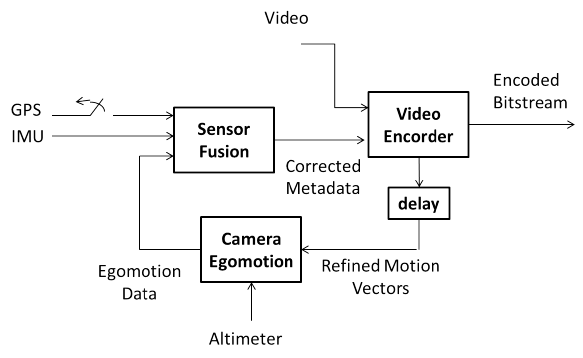
Figure 4: Metadata improvement by sensor